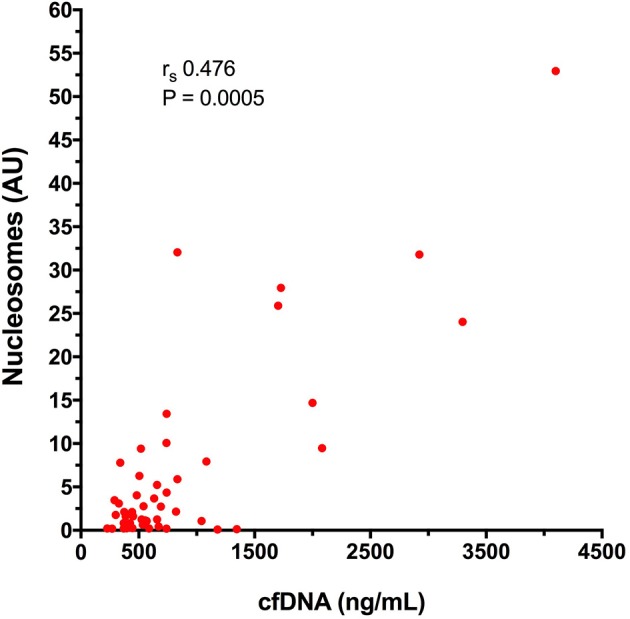
X-Y scatterplot of plasma cell-free DNA (cfDNA) concentration vs. plasma nucleosome concentration in arbitrary units (AU) from 49 dogs after moderate-severe trauma. Spearman's correlation coefficient (rs) with the associated P-value is displayed; P < 0.05 was considered significant.